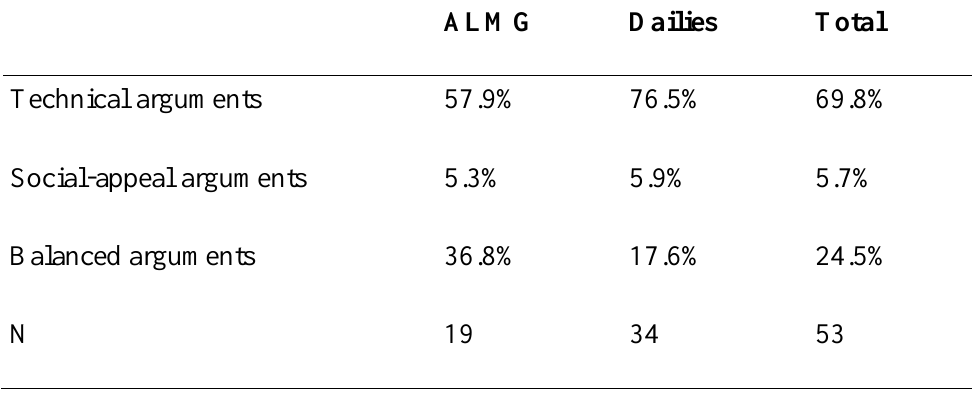
Table 3: Classification of experts’ reasons in each type of setting ALMG Dailies Total Technical